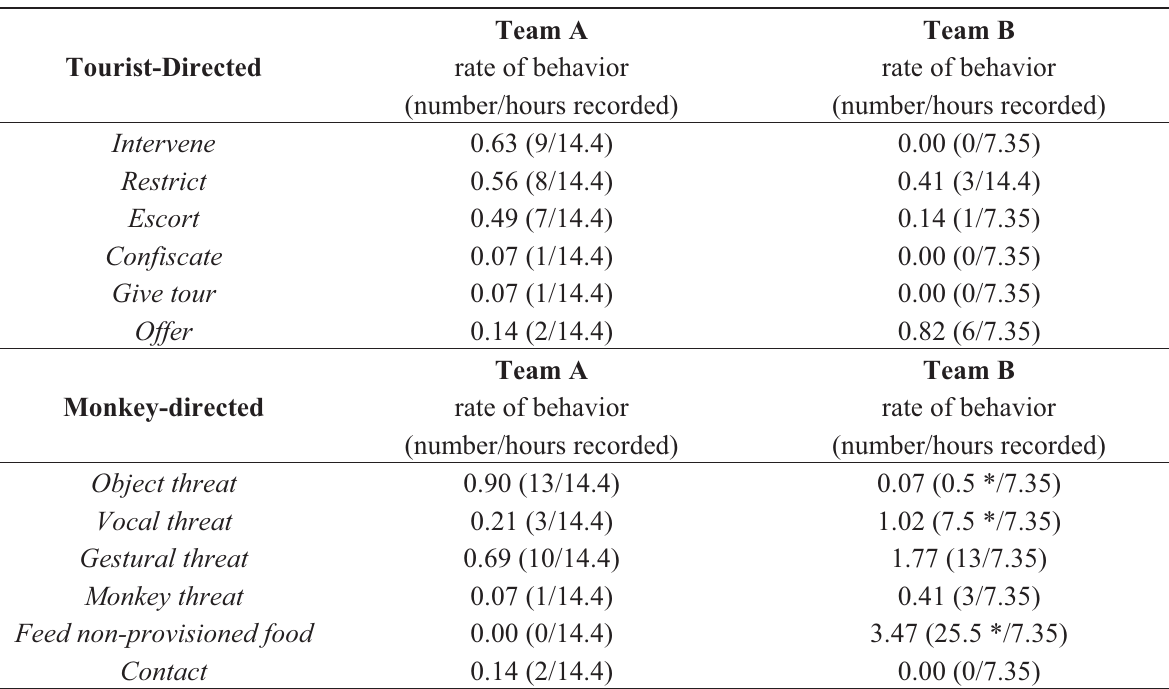
Table 2. Hourly rates of park ranger behaviors for ranger Teams A and B. Rates were adjusted for each